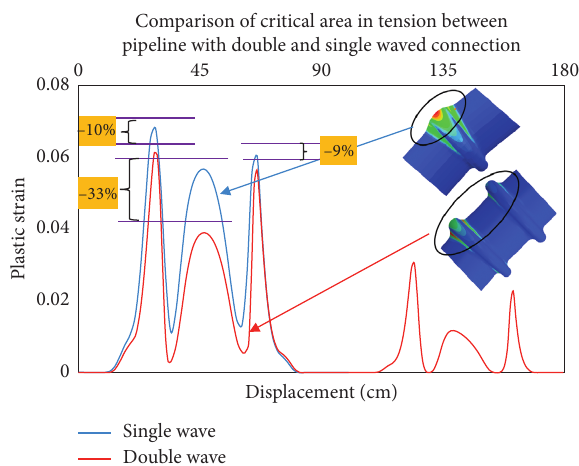
Figure 9: Contour of plastic strain on the critical area in tension. Figure 10: Contour of plastic strain on the critical area in